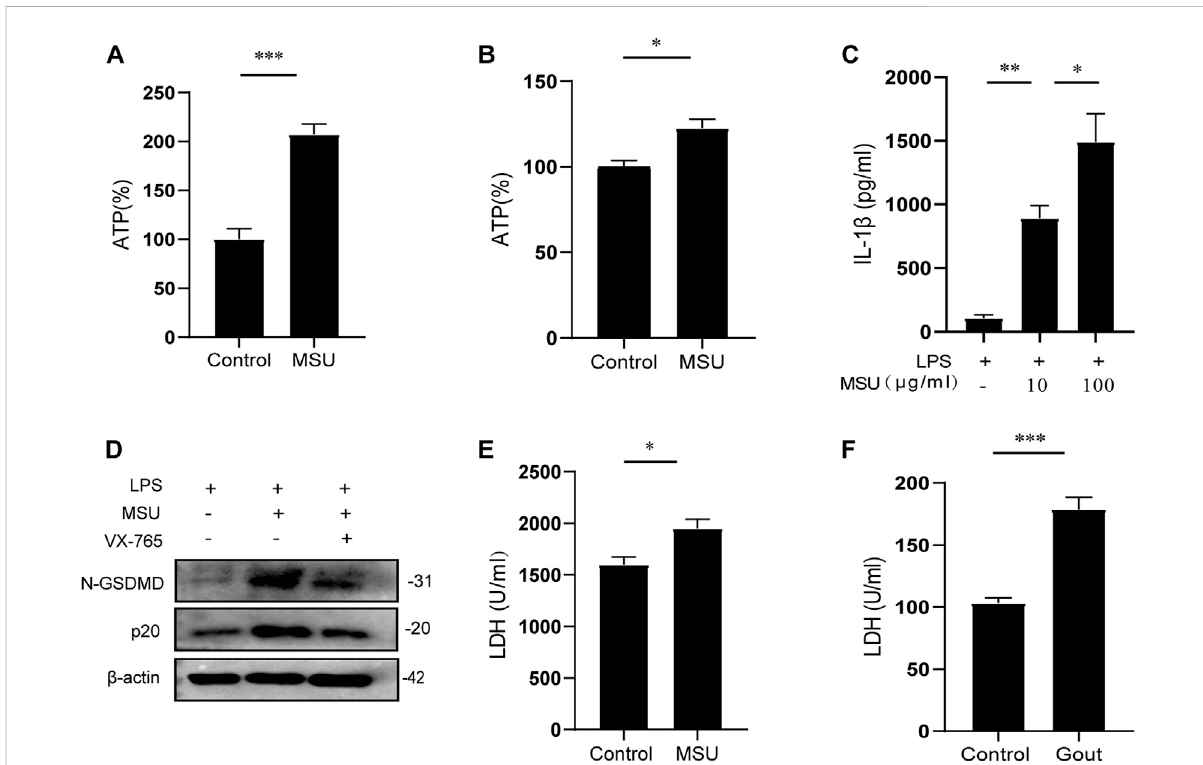
FIGURE. 4 MSU crystal stimulation induces ATP production and release. ATP (%) of cell cultures of PBMCs from MSU crystal (0.1 g/ml)-induced gouty arthritis rats (A) and LPS (50 ng/ml)-initiated, MSU crystal (100 μ g/ml)-stimulated stable gout patients (B) . Control groups were treated with equal amounts of sterile saline or PBS. The ATP (%) values of (A) and (B) are expressed as a percentage of the MSU group relative to the control group. (C) ELISA of IL-1 β in culture supernatants from LPS-primed PBMCs of gout patients treated with MSU (10/100 μ g/ml) for 4 h (D) WB of N-GSDMD and p20 expression in lysates from LPS-primed PBMCs of gout patients treated with VX-765 (pyroptosis inhibitor; 10 μ M) for 30 min and then stimulated with MSU (100 μ g/ml). LDH levels in the serum of MSU crystal-induced gout rats (E) and in acute-phase gout patients (F) . Data are presented as the means ± S.E.M.s. Statistics were analyzed using the independent samples t test or Dunnett ’ s t test. (A,B) n = 3-4; (C) n = 4; (E) n = 5; (F) n = 19. * p < 0.05; ** p < 0.01; *** p <